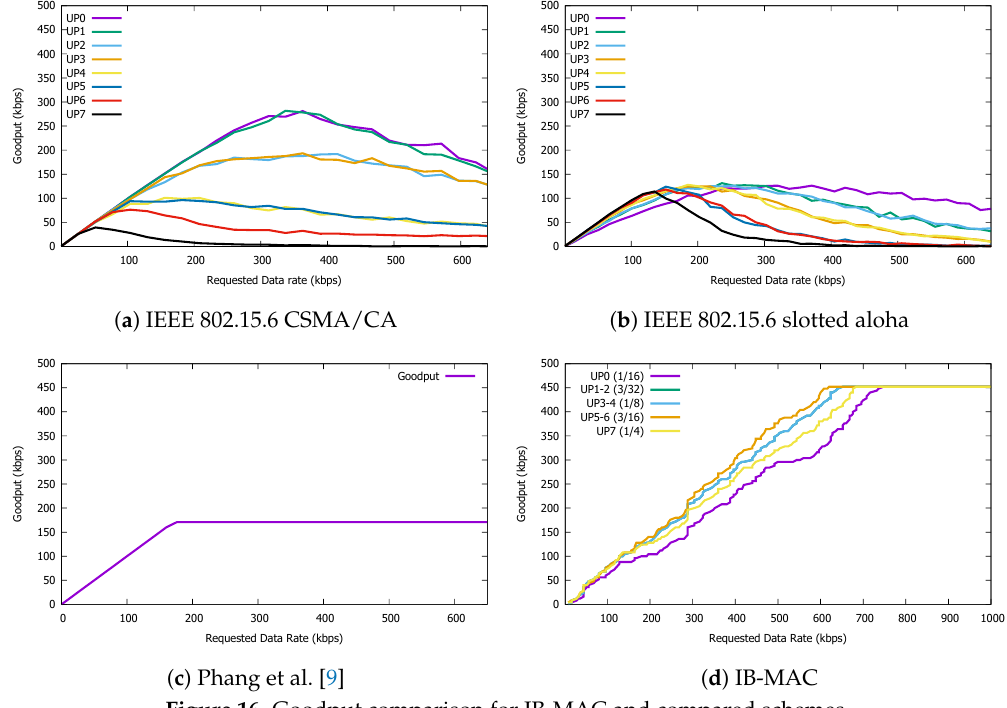
Figure 16. Goodput comparison for IB-MAC and compared